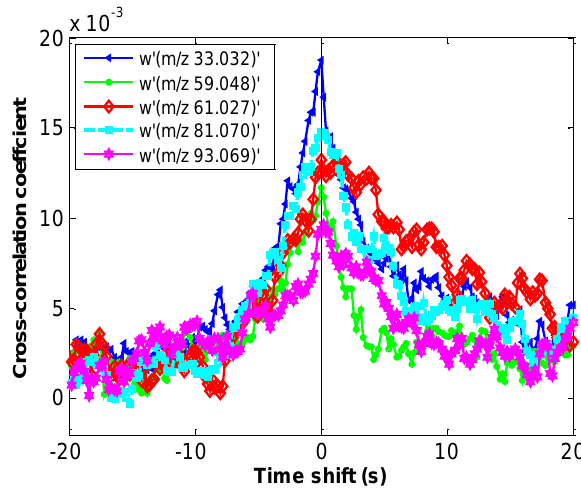
Fig. 3. Cross-correlation plots of vertical wind speed and concentration for the five most dominant flux compounds ( m/z 33.032, 59.048, 61.027, 81.070 and 93.069) observed by PTR-TOF-MS, av- eraged over 10:00–16:00 PST throughout the whole measurement